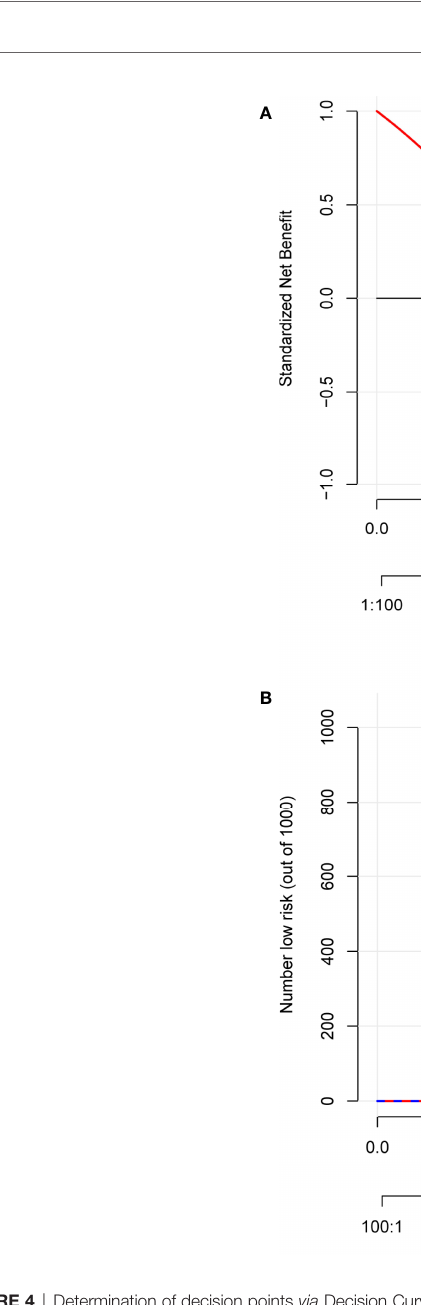
FIGURE 4 | Determination of decision points via Decision Curve Analysis (DCA) and Clinical Impact Curve (CIC). (A) DCA for the prediction model (EI-Score). The decision curve analysis graphically shows the clinical usefulness of the EI-Score based on a continuum of potential thresholds for central lymph node metastasis (CLNM) (x-axis) and the net bene fi t of using the EI-Score to stratify patients (y-axis). Net bene fi t curves are plotted across probability thresholds for 7 options: ‘‘ treat all ’ assume all patients have CLNM, ‘ treat none ’ assume no patients have CLNM, treat according to combined clinical factors (age, gender, tumor size, HT), Age, Gender, size, HT and EI-Score. Net bene fi t = (true positives/N)- (false positives/N) *(weighting factor). Weighting factor = Threshold probability/(1-threshold probability). (B) CIC for EI-Score. The red line shows the total number who would be deemed as low risk of CLNM for each risk threshold. The blue line shows how many of those would be true positive (without